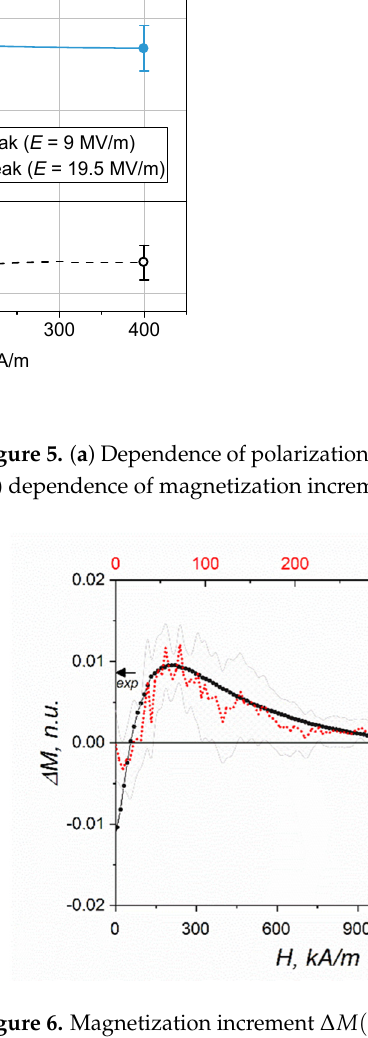
Figure 6. Magnetization increment Δ𝑀(𝐻) = 𝑀(𝐻) (cid:3006) − 𝑀(𝐻) (cid:2868) , normalized units under an electric bias of 5 MV/m; experimental data (black) and simulation data (red) with error bars (grey).